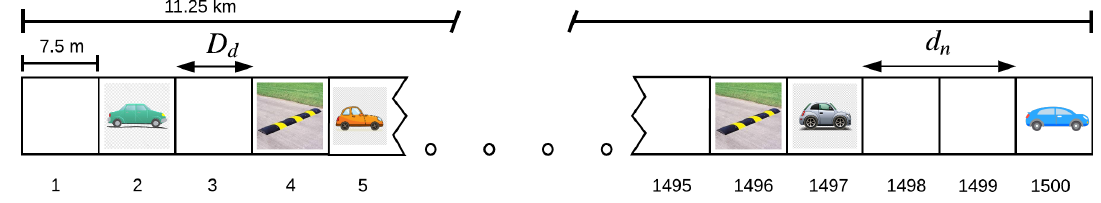
Figure 2. A sketch of the model, where the road is represented by an array of L = 1500 equivalent to a lane of 11.25 km. Here, d n is the spatial-headway and D d is the number of empty cells between a vehicle and the closest speed hump